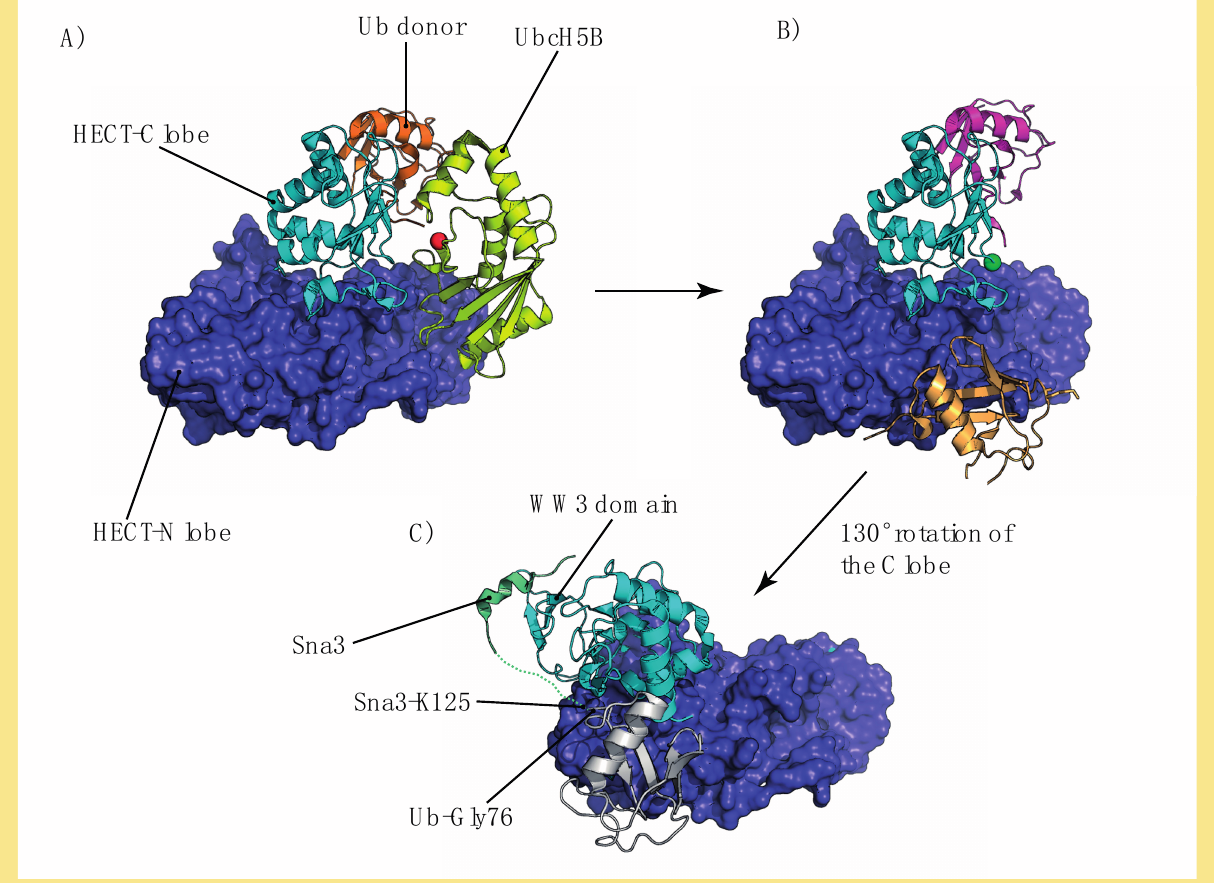
Figure I. Model of substrate ubiquitylation or polyubiquitylation by UbK63 chains by enzymes of the HECT- domain E3 family. ( A ) The HECT N lobe binds the charged UbcH5B-Ub (active cysteine represented by a red sphere) thioester (PDB code 3JW0) and transfers Ub ( B ) to the catalytic cysteine (green sphere) in the C lobe (PDB code 4BBN). ( C ) The C lobe-Ub thioester then rotates 130° to bring the donor Ub to the